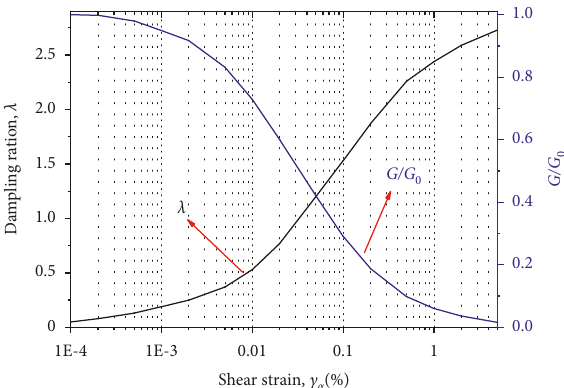
Figure 3: The curves of G / G and